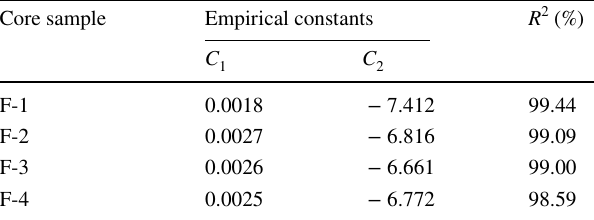
Table 2 Empirical constants from least square power law curve fit Core